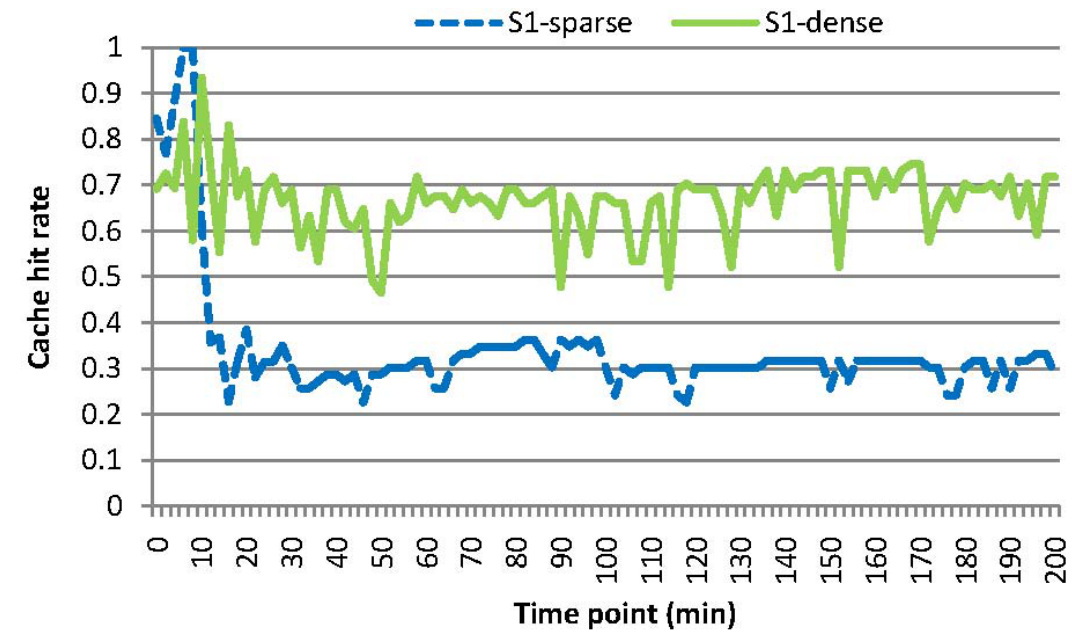
Figure 10. Comparison of cache hit rates for S1 - sparse and S1 - dense , where S1 - sparse means sparse sub-regions with our cache mechanism, and S1 - dense means dense